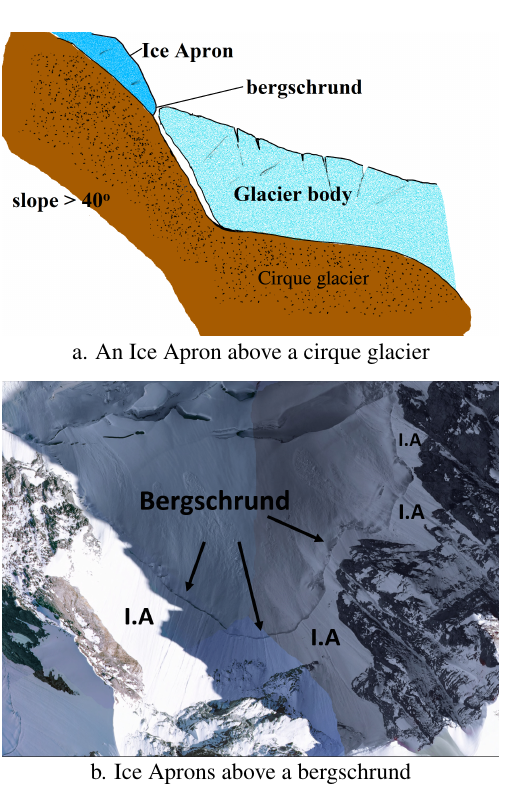
Figure 5. Ice Aprons in relation to steep slope